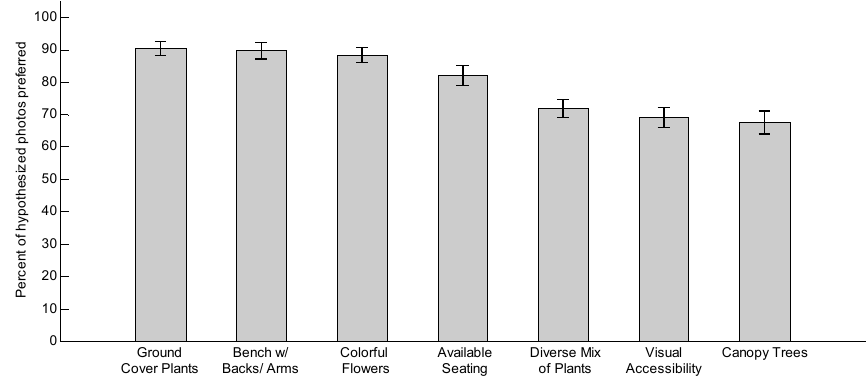
Figure 12. Mean for hypothetically preferred features with 95% confidence interval error bars.